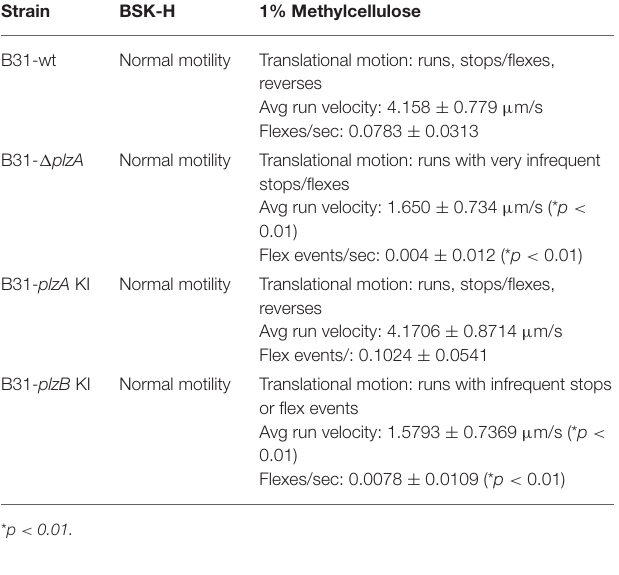
TABLE 2 | Motility patterns and observations. Strain